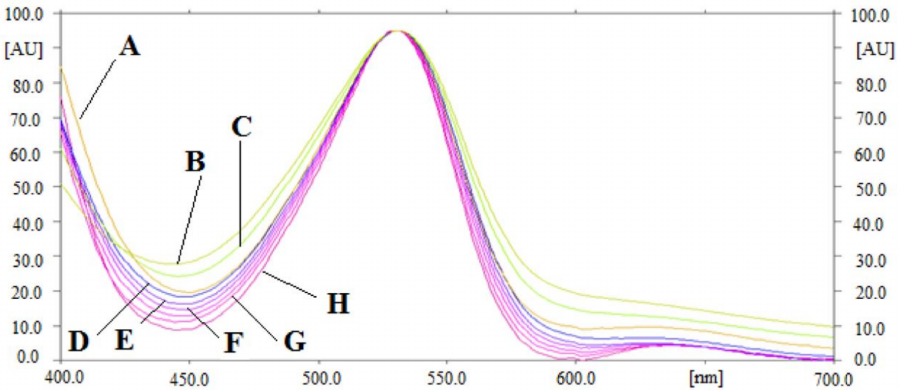
Figure 3. UV absorption spectra of (A) standard thymol, (B) essentail oil of Origanum vulgare (SA), (C) essentail oil of Thymus vulgaris (SA), (D) UBE of Origanum vulgare (SA), (E) UBE of Thymus vulgaris (SA), (F) TE of Origanum vulgare (SA), (G) TE of Thymus vulgaris (SA), and (H) commercial formulation,